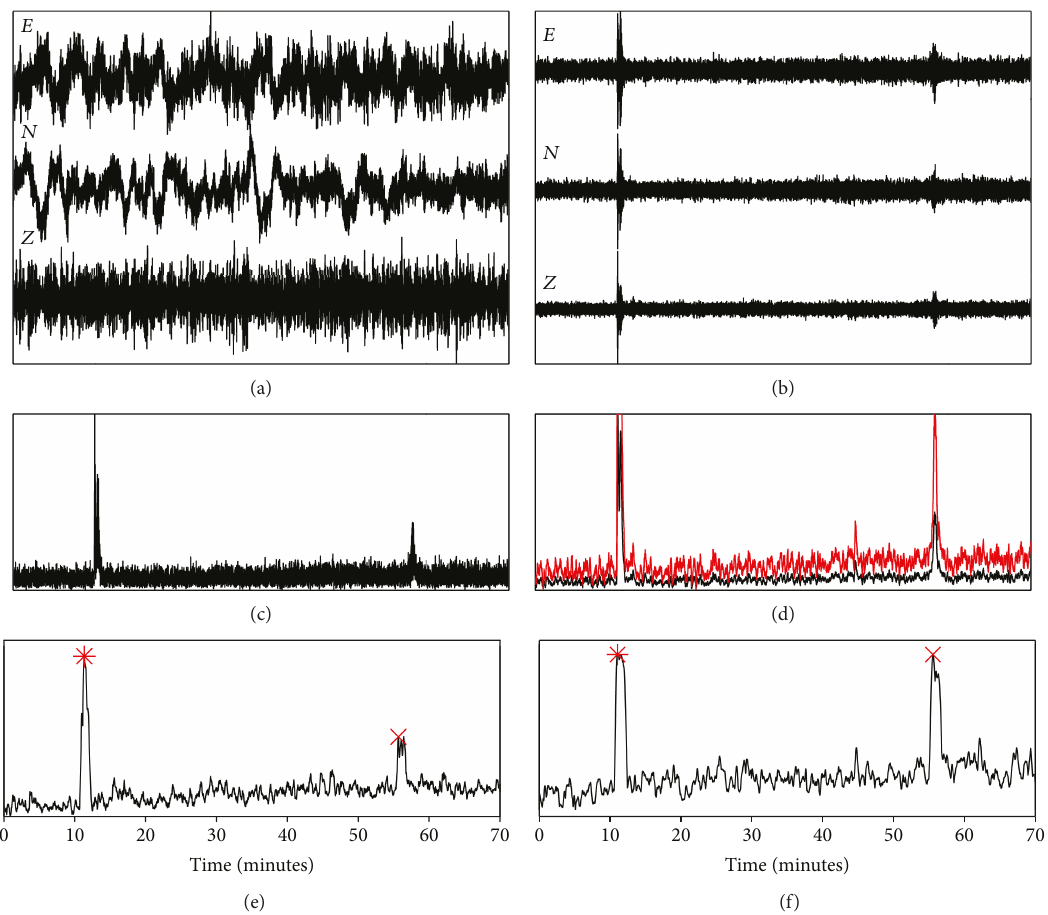
Figure 5: An example of the seismic data preprocessing (section 3.1) and the landslide detection (section 3.2) stages. (a) 3-component raw recordings are cut into 70-minute-long segments with 10-minute-long overlaps. (b) Waveforms bandpassed between 1 to 3Hz. (c) The root mean square (RMS) of three-component bandpass- fi ltered waveforms. (d) Envelopes obtained by normalizing using the maximum (black line) and by normalizing using the value at the 99th percentile (red line). (e) The stacking function obtained from envelopes normalized by the maximum. (f) The stacking function obtained from envelopes normalized by the value at the 99th percentile. Stars: a local earthquake ( M 3.6). Crosses: a landslide event detected by our L